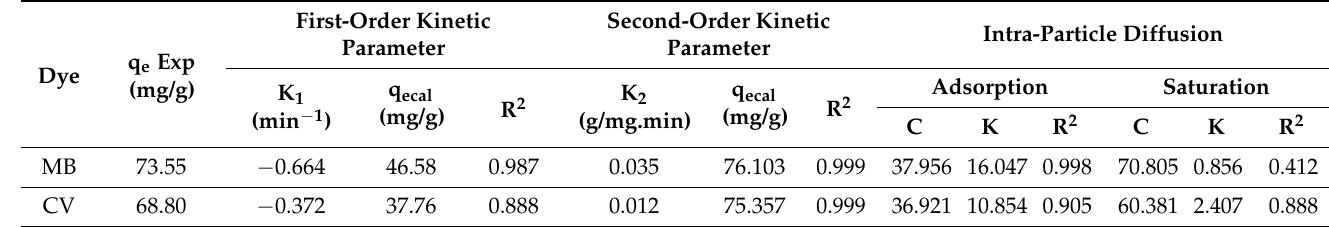
Table 2. Adsorption kinetics and diffusion mechanism for removal of MB and CV-dyes.